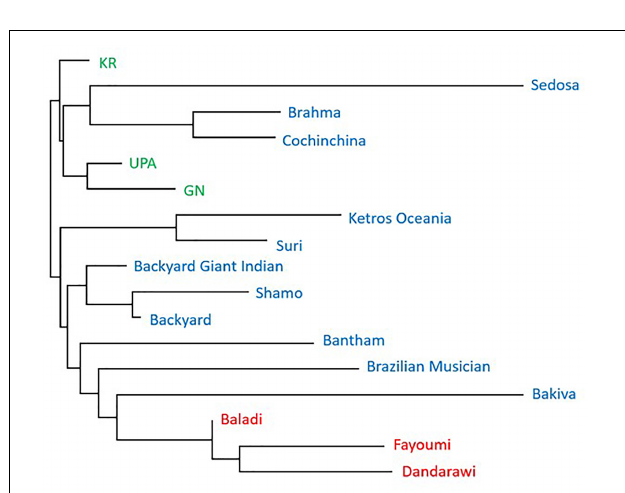
FIGURE 3 | Reynolds’ genetic distances population tree of three Sril Lanka ecotypes (Green), three Egyptian breeds (Red), and eleven Brazilian breeds/ecotypes